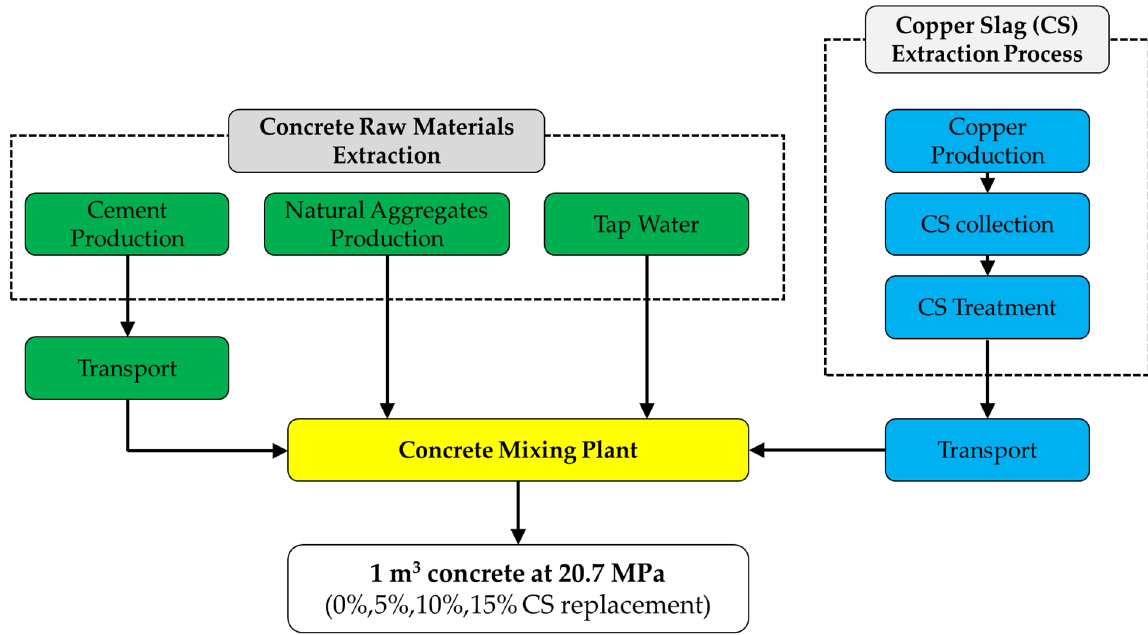
Figure 1. System boundaries of 20.7 MPa concrete production.